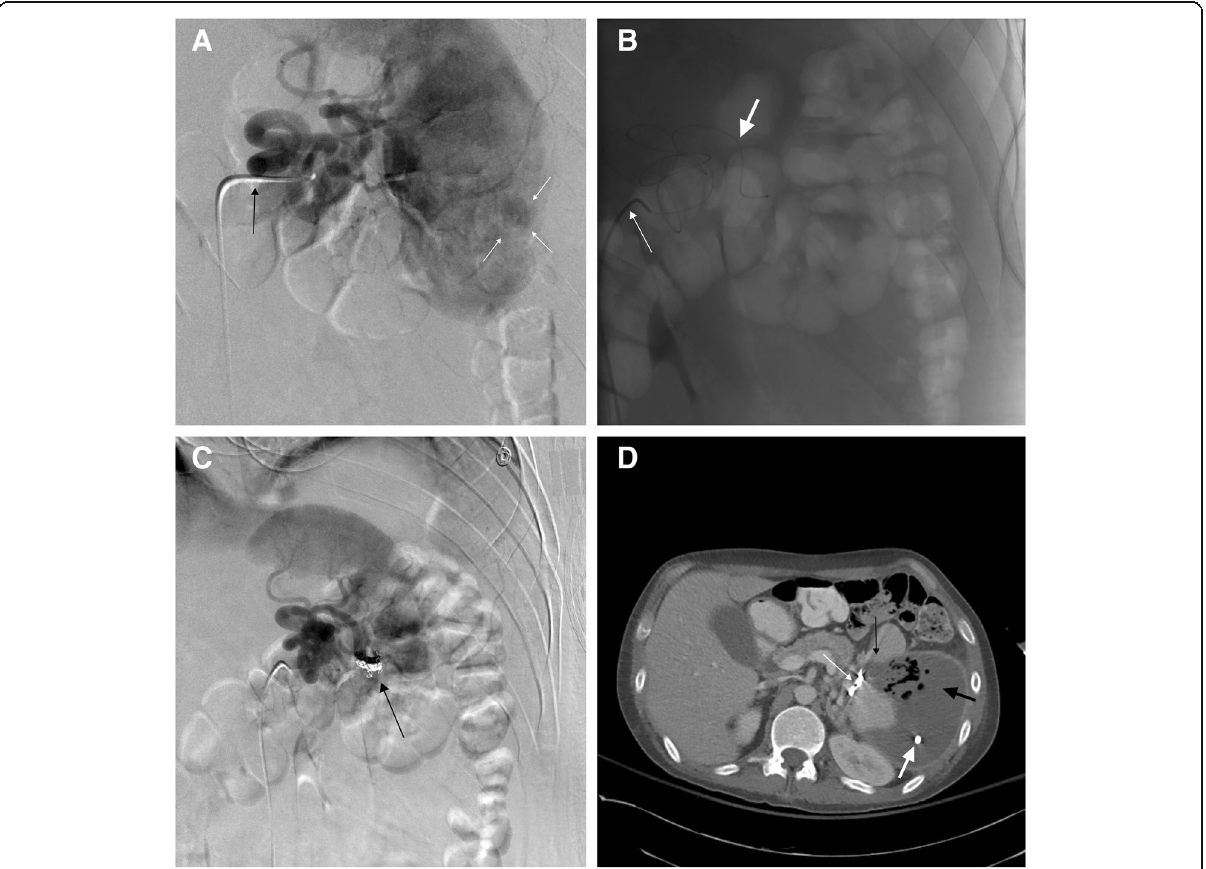
Fig. 11 37 year old male with an AAST grade III splenic injury following high speed motor vehicle crash. a Splenic artery DSA with a catheter in the splenic artery (black arrow) demonstrating a focal pseudoaneurysm (white arrows). b A base catheter in the splenic artery (small white arrow), with a 5 F microcatheter fed through a tortuous splenic artery (large white arrow). The tortuosity and distance of this pseudoaneurysm precludes